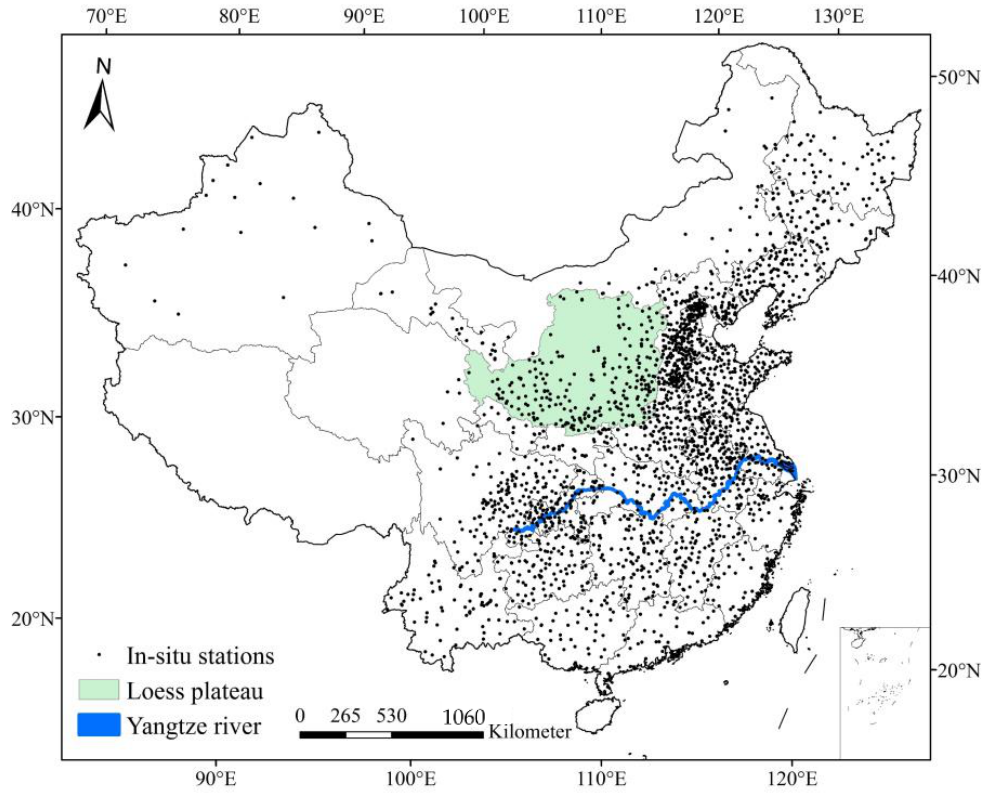
Figure 2. Overview of the study area and the distribution of in situ field capacity measurement